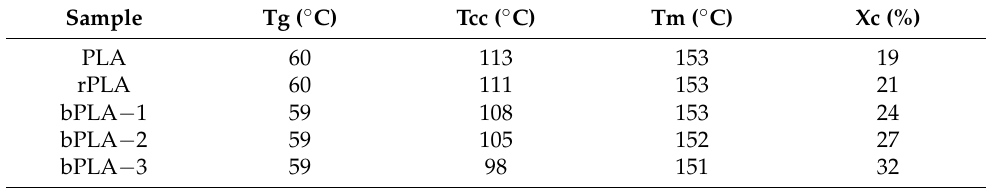
Figure 9. DSC curves for rPLA and bPLA samples during the second heating step. The curves are vertically shifted for easier comparison. Table 3. Thermal properties of rPLA and modified rPLA as function of GMA